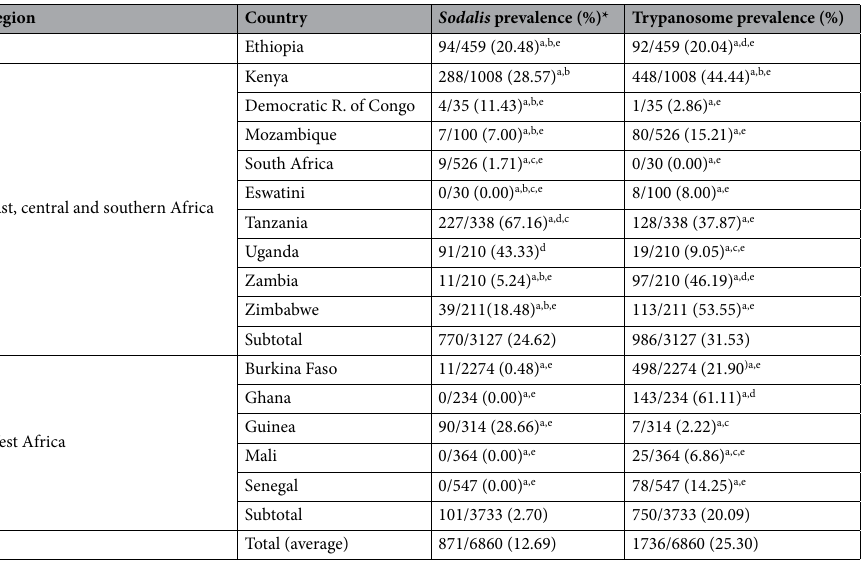
Table 1. Global prevalence of Sodalis and Trypanosomes in tsetse samples analyzed per country. * Values indicated by the same lower-case letter do not differ significantly at the 5%